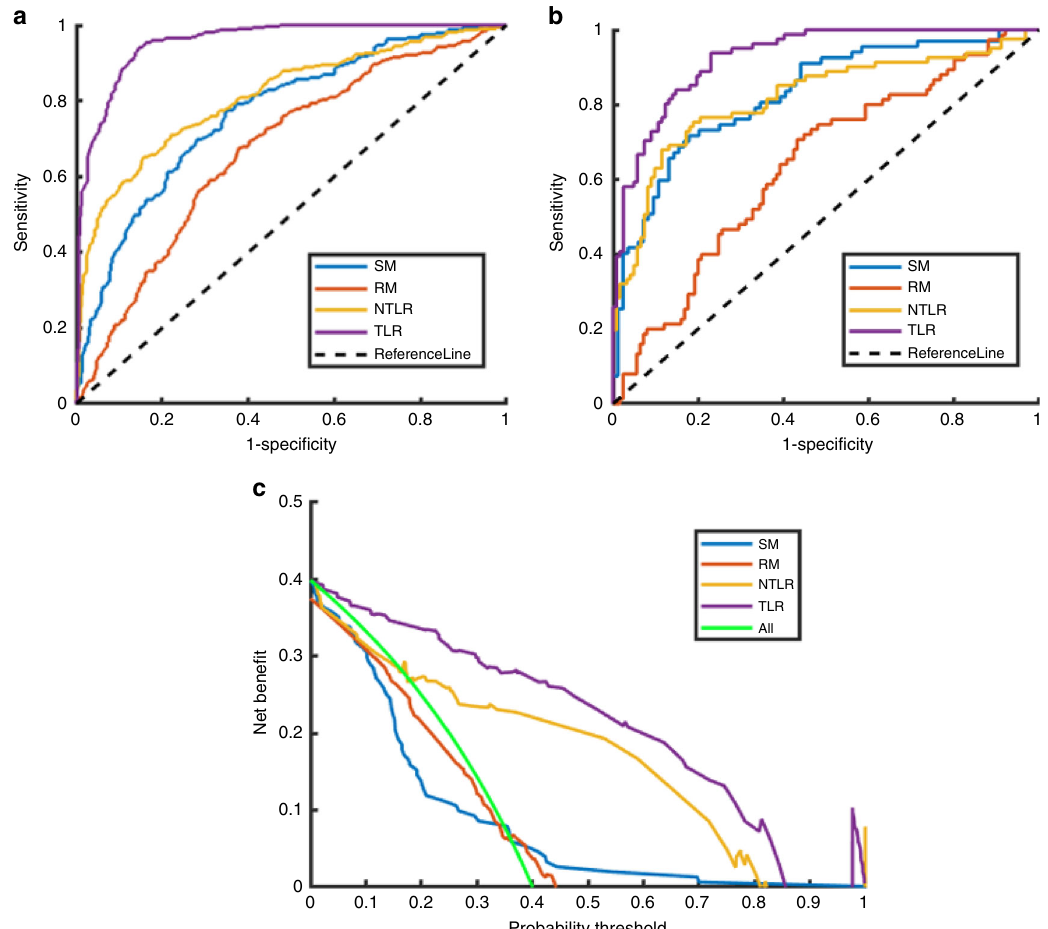
Fig. 1 Comparison of ROC curves of LNM prediction in the main cohort by four models. a ROC curves in the cross-validation set, b ROC in testing set, and c decision curves in the testing set. (SM statistical model, RM traditional radiomics model, NTLR nontransfer learning radiomics, TLR transfer learning radiomics). Table 1 Quantitative indexes of four models on main cohort data.